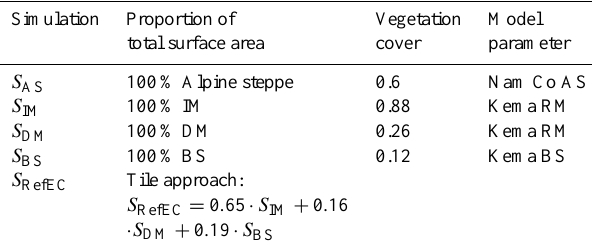
Table 6. Overview of model scenarios conducted with SEWAB and SVAT-CN for Kema site, periods 2010 and 2012 and Nam Co 2009. The numbers for vegetation fraction and the tile approach have been derived by the classification survey described in Sect.